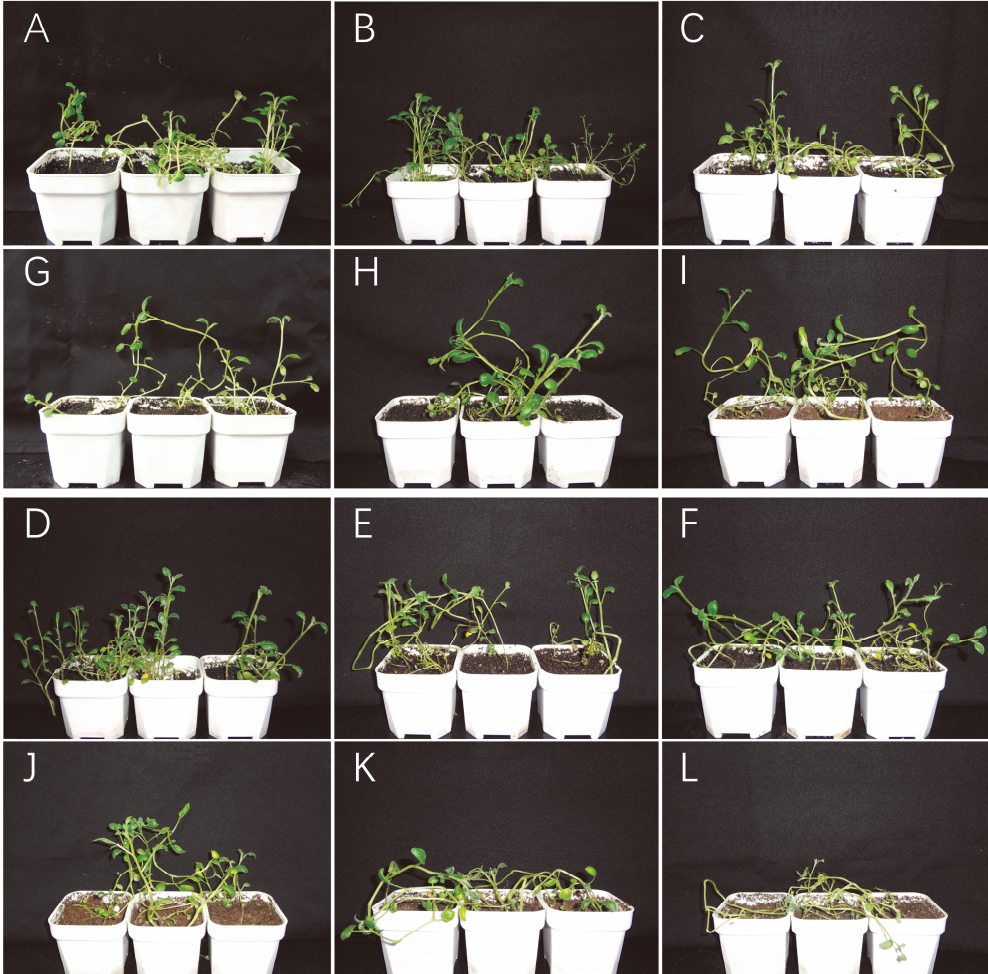
Figure 8. Potato seedlings treated with drought stress and watering in six periods. ( A – F ) are used to represent the variety of Desiree seedlings with watering for 0 days, 4 days, 8 days, 12 days, 16 days and 20 days, respectively. ( G – L ) to represent Desiree seedlings of potato varieties treated with drought stress for 0 days, 4 days, 8 days, 12 days, 16 days, and 20 days,